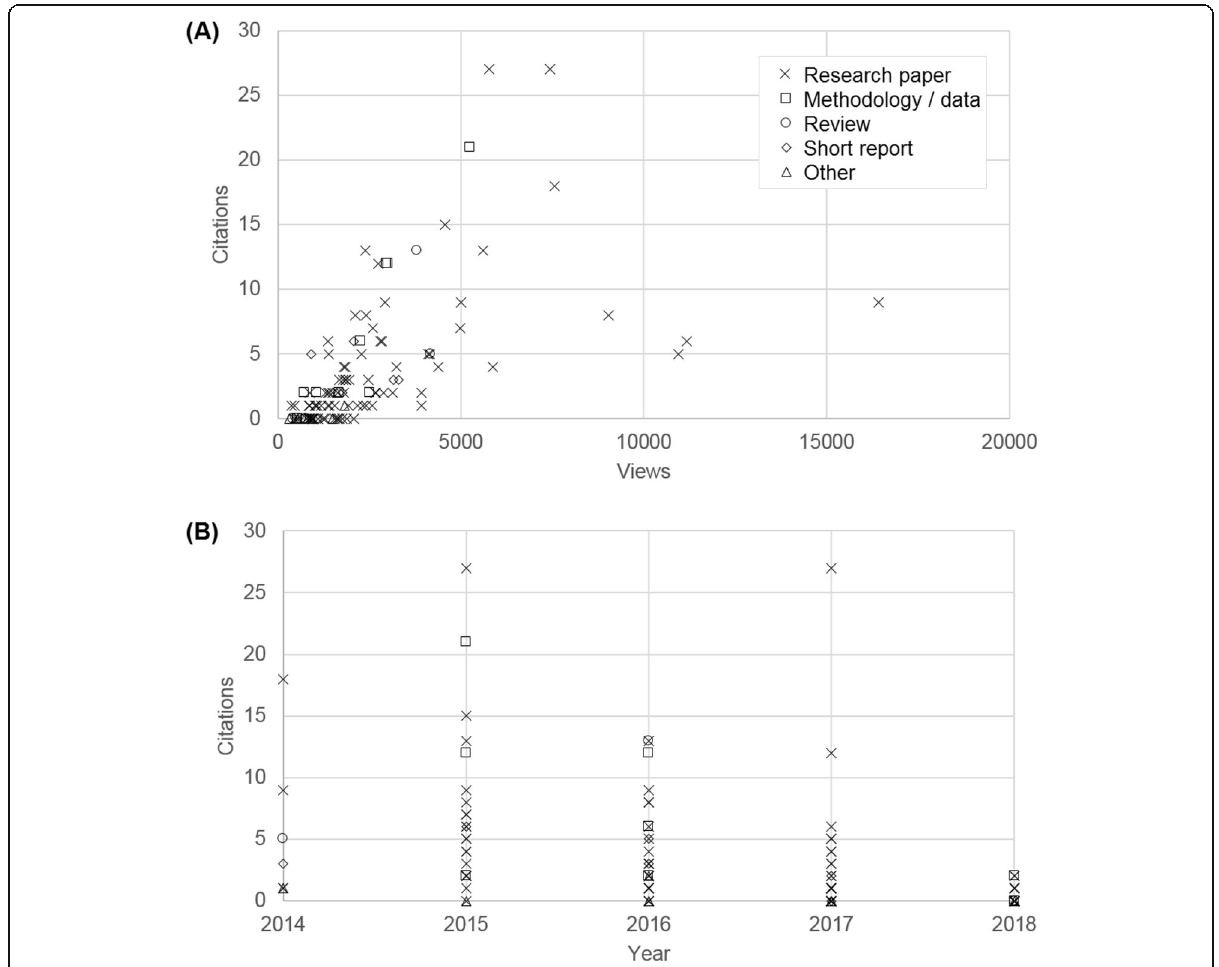
Fig. 4 The relationship between views and citations for different types of papers published (Part ( a )) and citations obtained by years (Part ( b